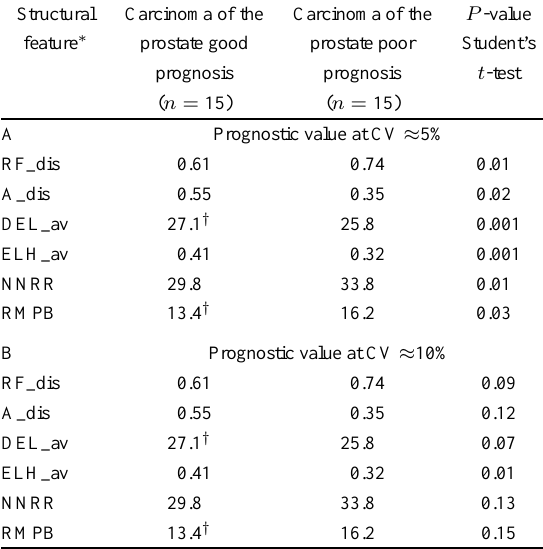
The prognostic in altogether 30 cases of carcinomas of the prostate of 6 structural features as related to the CV at 20 repeated computa- tions. The number of cells included that yield a CV (cid:25) 5% (Panel A) gives a significant prognostic value ( P < 0 : 05). For all the struc- tural features except ELH_av, the prognostic value is no longer